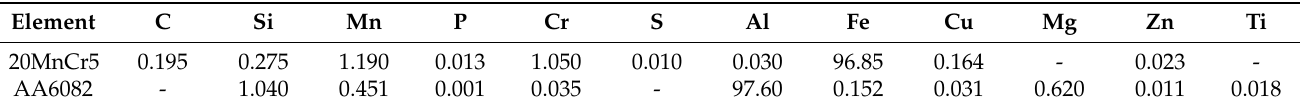
Table 2. Chemical composition of the 20MnCr5 steel and AA6082 aluminum alloy in wt.%., measured by optical emission spectrometry.